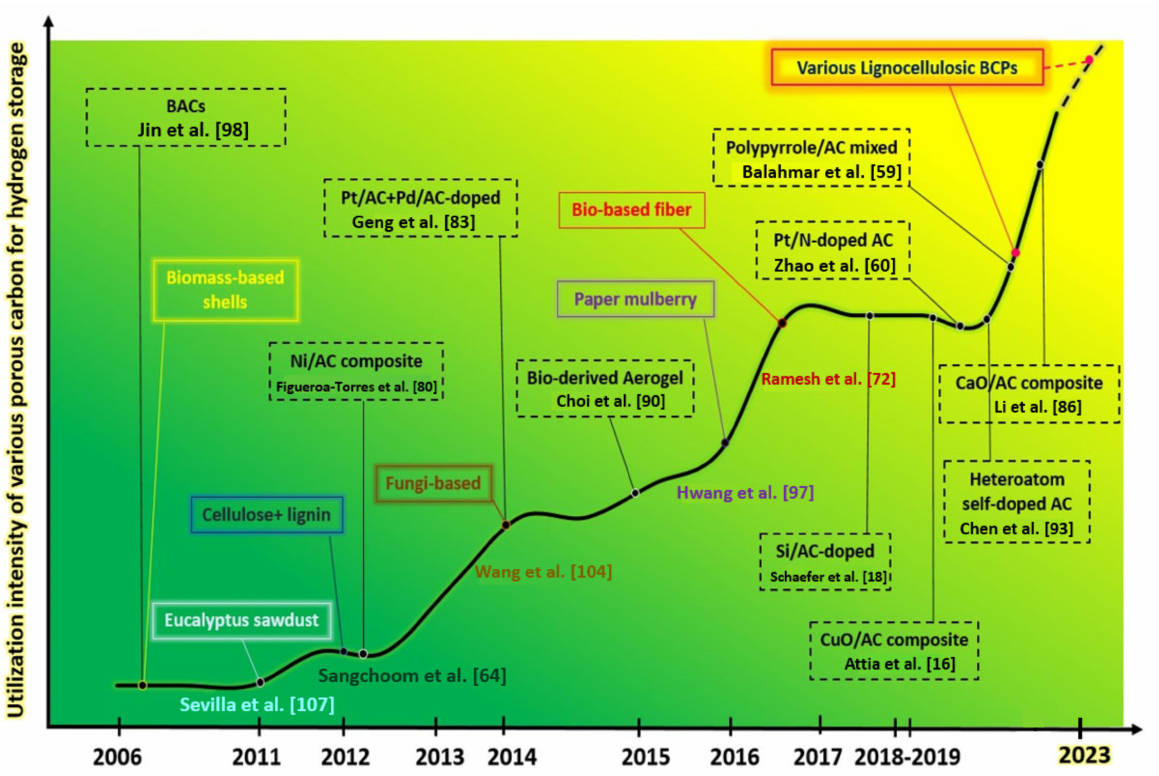
Figure 7. The review of studies utilized various precursors to synthesize various porous adsorbent materials for hydrogen storage